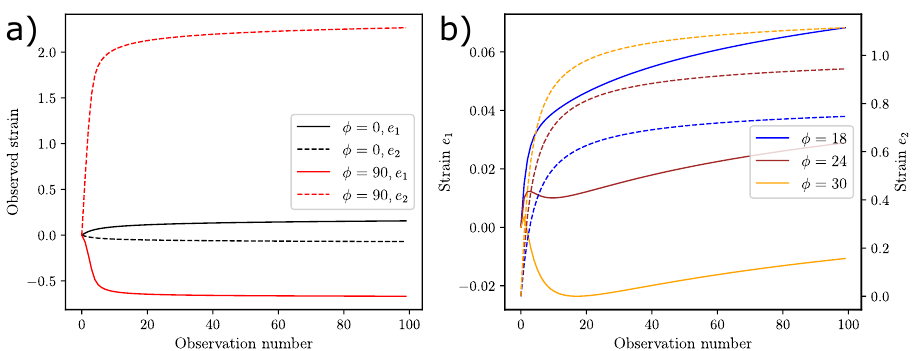
Figure 5. Representative observations from the model with k 1 = 40 kPa and k 2 = 40. ( a ) The observations using angles φ = 0 and 90 degrees, with the latter covering a significantly larger range. ( b ) The change in observations the angle is changed from 18, 24 to 30 degrees shows a transition in e 1 from positive to negative values, indicating a coupling between the two directions. Note that e 1 is shown here in solid lines (left y-axis) and e 2 is shown in dashed lines (right y-axis).